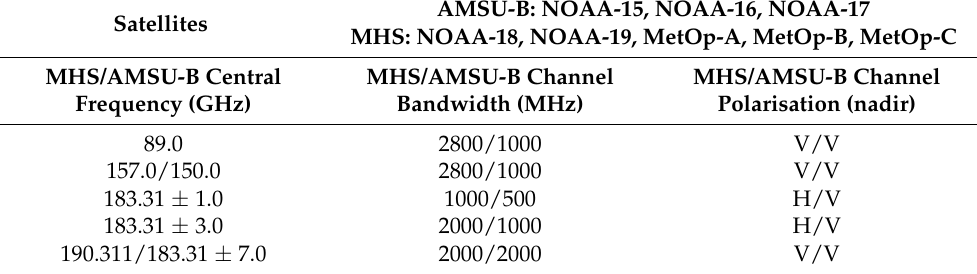
Table 1. AMSU-B and MHS radiometers’ characteristics.